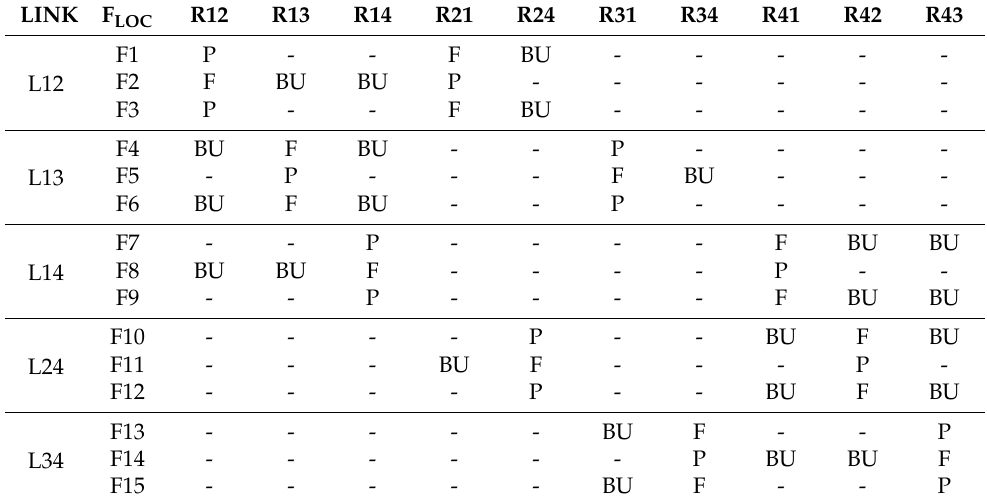
Table 3. Performance of the proposed protection system against different 0 Ω PtG fault cases. Fault detection time in milliseconds.